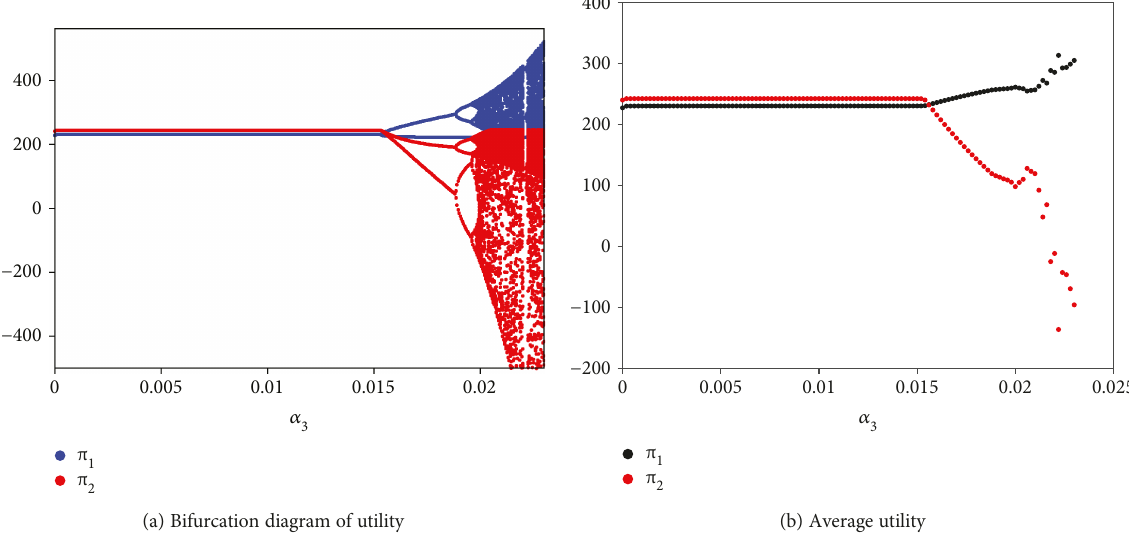
Figure 9: The evolution process of the two retailers ’ utilities with α